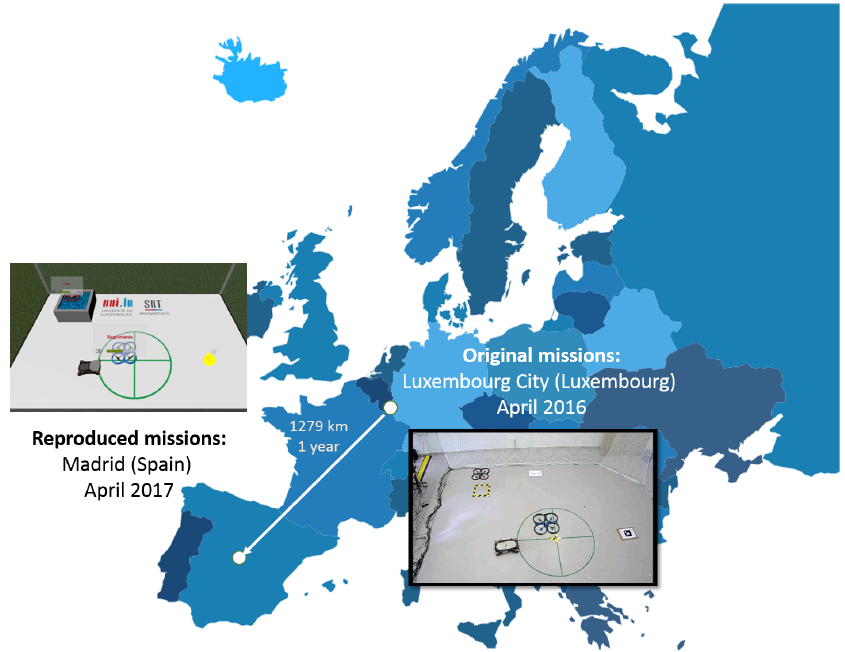
Figure 1. Multi-robot missions performed in Luxembourg in 2016 and virtually reproduced in Madrid in